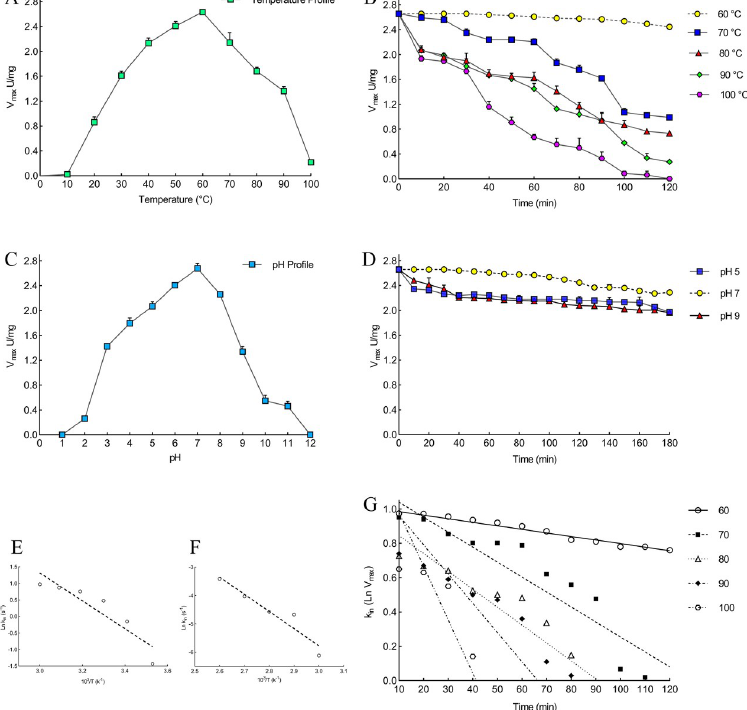
Fig 9. Effect of temperature and pH on the recombinant protease 1147. Effect of temperature on the recombinant protease 1147 (A) activity (B) stability. Effect of pH on the recombinant protease 1147 (C) activity (D) stability. The optimum temperature and pH were 60˚C and 7, respectively. (E) Arrhenius plots for E a‡ . (F) Arrhenius plots for E a# . (G) Thermal inactivation Ln at 60, 70, 80, 90, and 100˚C.